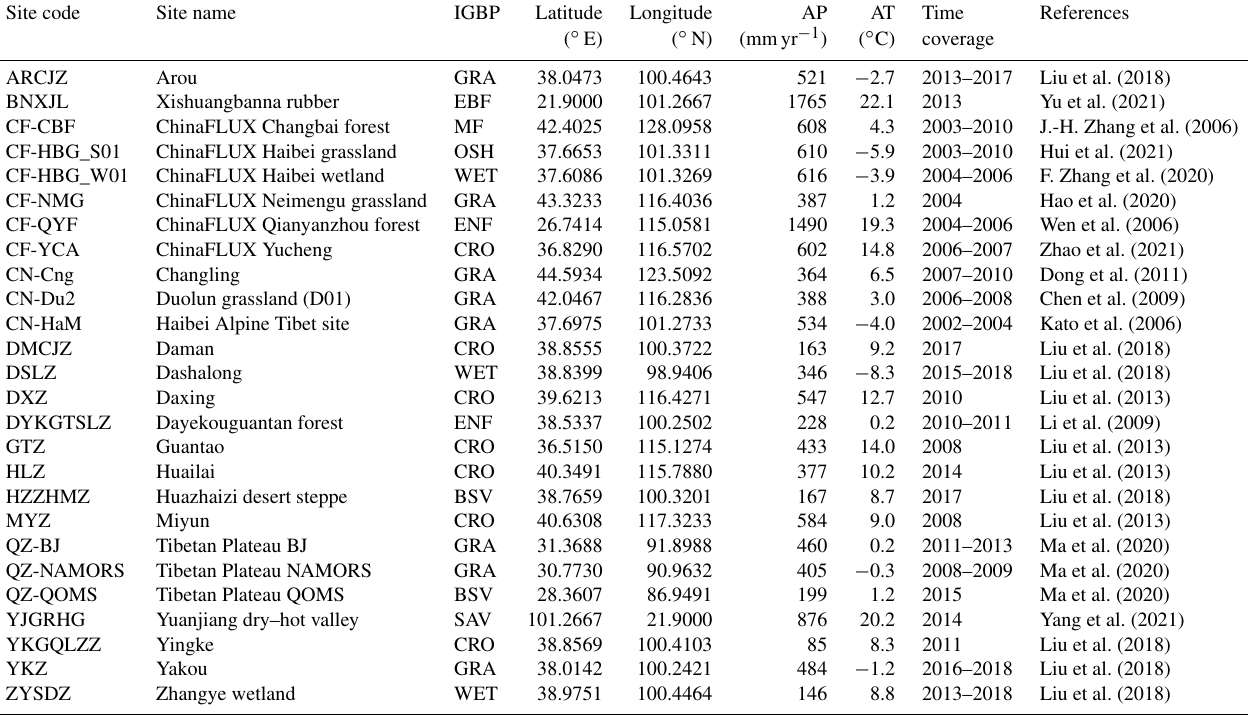
Table 2. Details of 26 EC flux towers employed in this study. Note that AP indicates mean annual precipitation and AT refers to mean annual temperature in its observed